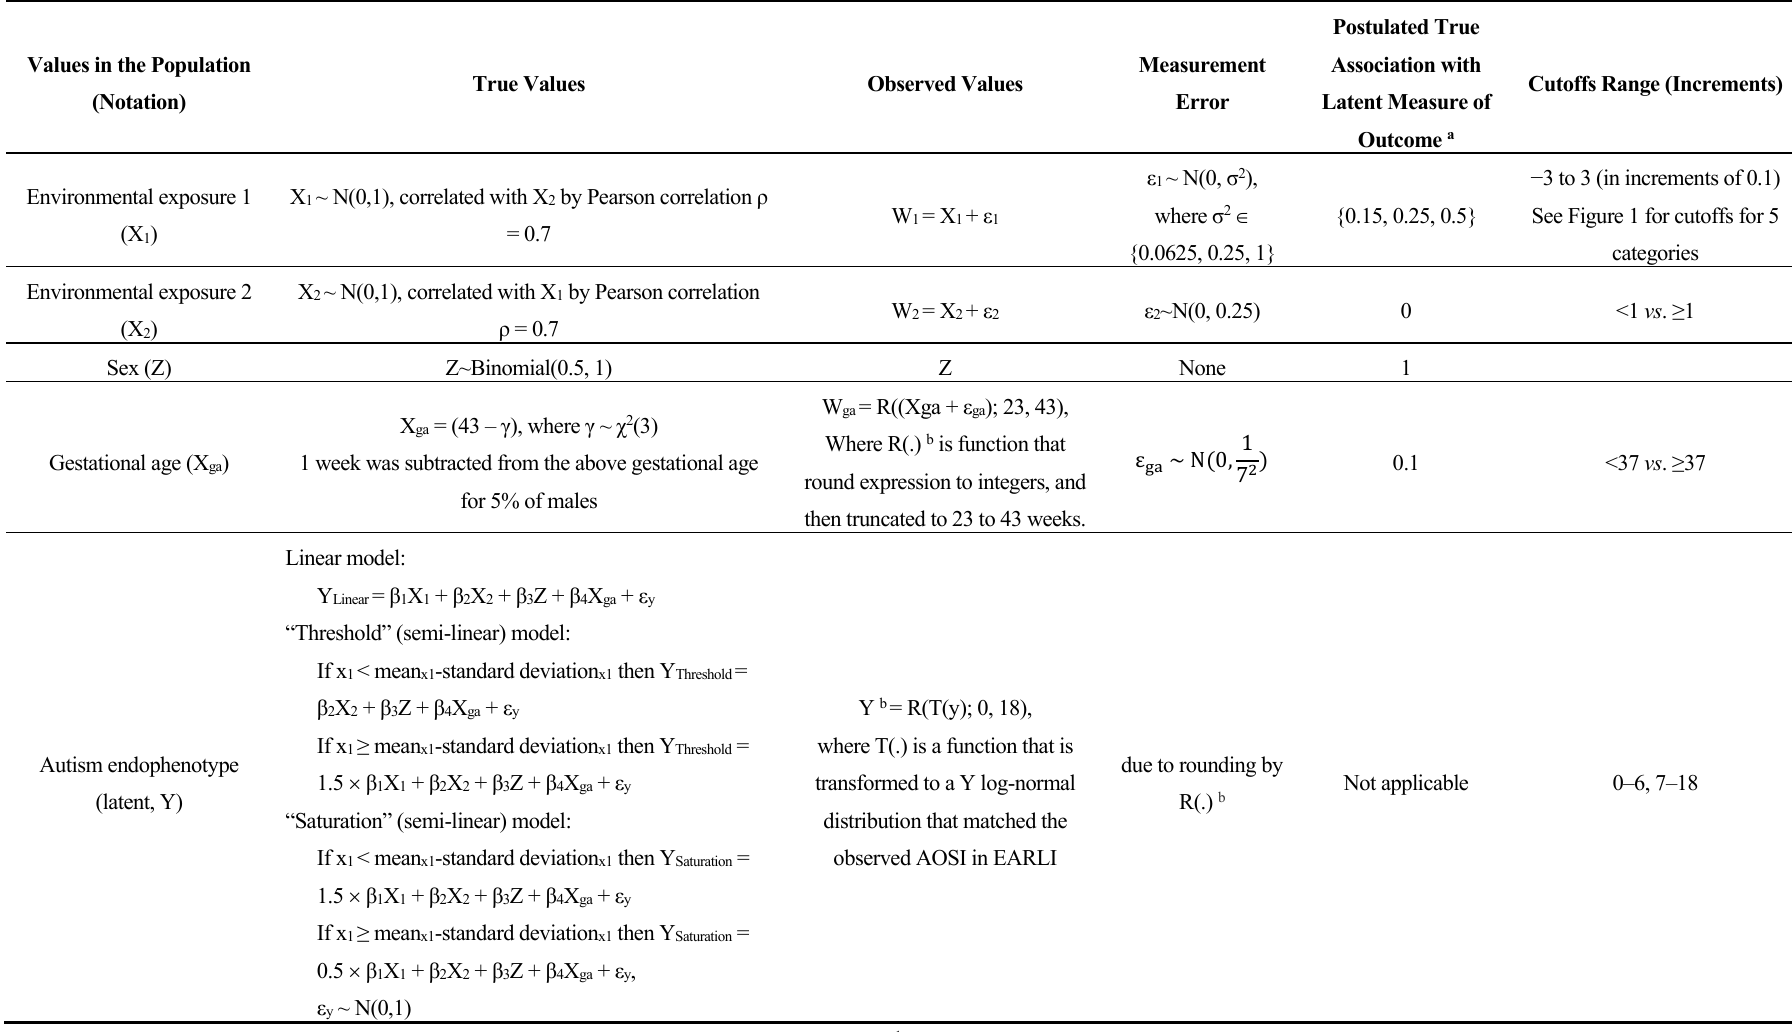
Table 1. True and observed values in the simulated